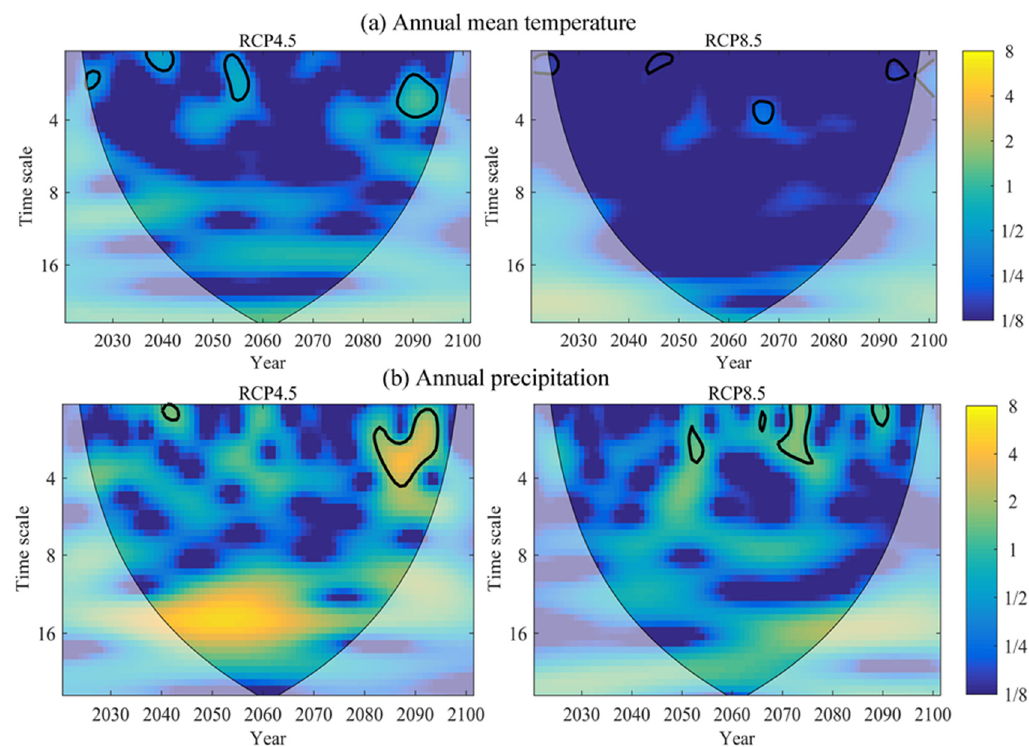
Figure 9. Continuous wavelet power spectrum of annual precipitation ( a ) and annual temperature ( b ) under the RCP4.5 and the